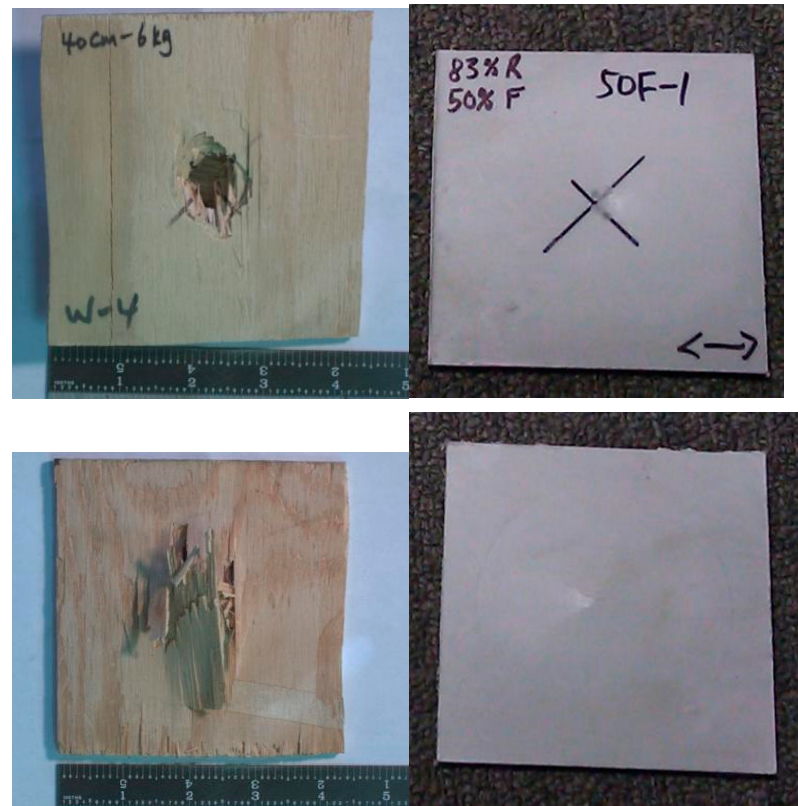
Figure 19. LVI response of plywood ( left ) compared with an 83% recycled content PP-GF ( right ) impacted at 24 J impact. The top row is the strike face; the bottom row is the back face. The sample size is 150 mm × 100 mm (6 ″ × 4 ″ ) Figure 20 provides a comparison of load–time curves for the LVI response of recycled PP-GF, plywood, and 30 wt% LFT PP-GF. It can be noted that the PP-GF recycled plate was almost equivalent to the response of LFT virgin, the highest performing. Plywood absorbed the least amount of energy.